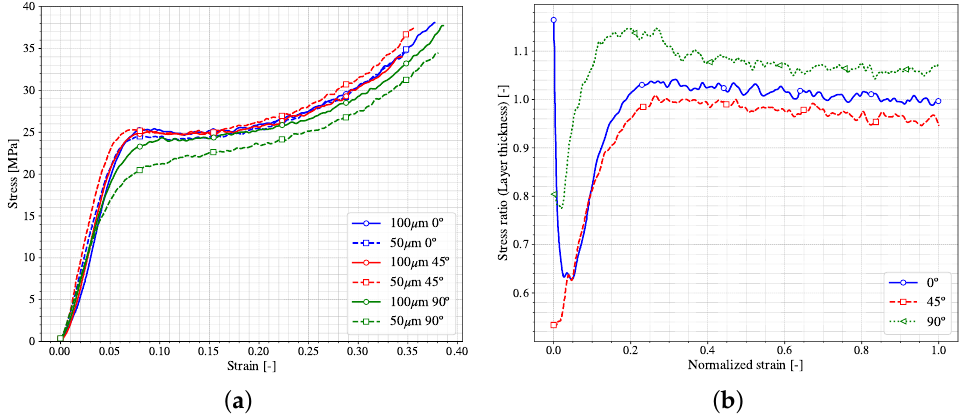
Figure 12. Layer height effects on stress-strain compression results. ( a ) σ vs. ε ; ( b ) ratio of